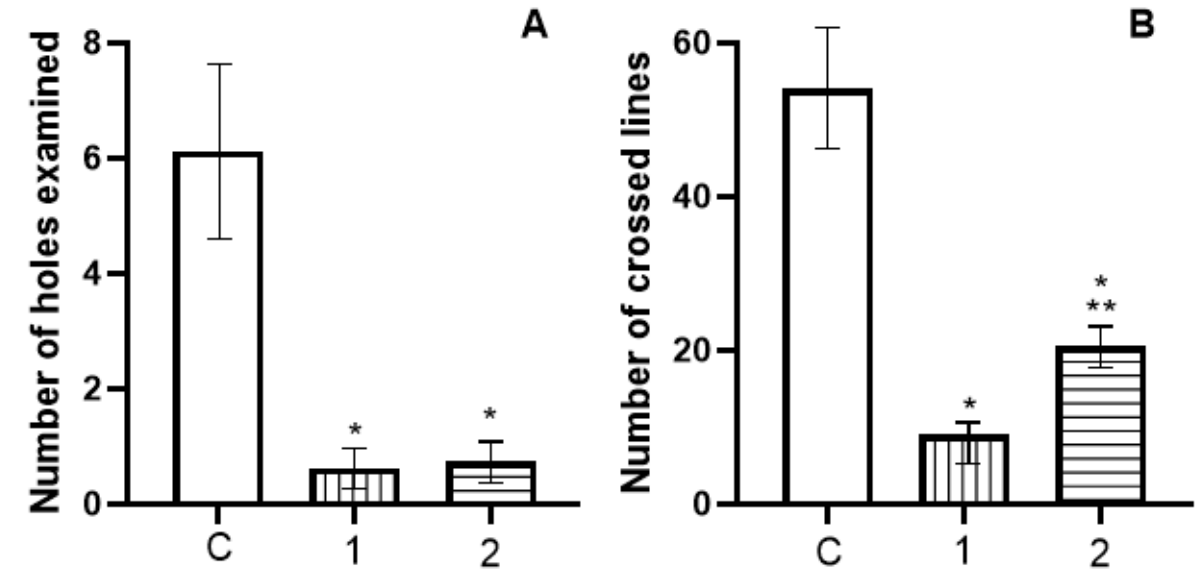
Figure 9. Indicators of research ( A ) and motor ( B ) activity of rats in the «Open field» after intranasal administration of haloperidol. On the abscissa—groups of animals: C—control (saline, intranasally, n = 8); 1—intranasal haloperidol 0.5 mg/kg, n = 8; 2—intranasal haloperidol with nanoparticles, 0.5 mg/kg, n = 8. The ordinate is the number of peeks into the holes ( A ) and the number of line crossings ( B ). *—statistically significant differences in relation to the control group (C) at p < 0.05; **—statistically significant differences in relation to group 1 (haloperidol) at p <